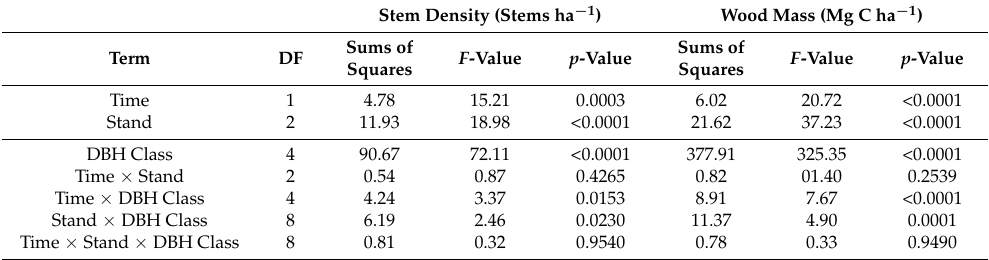
Table A2. Full factorial three-way ANOVA results for stem density (stems ha − 1 ) and wood mass (Mg C ha − 1 ). We tested for the effect of time (before and after disturbance), different stands, DBH classes, and all interaction terms. Analyses were performed on log-transformed values. Significant differences are in bold.